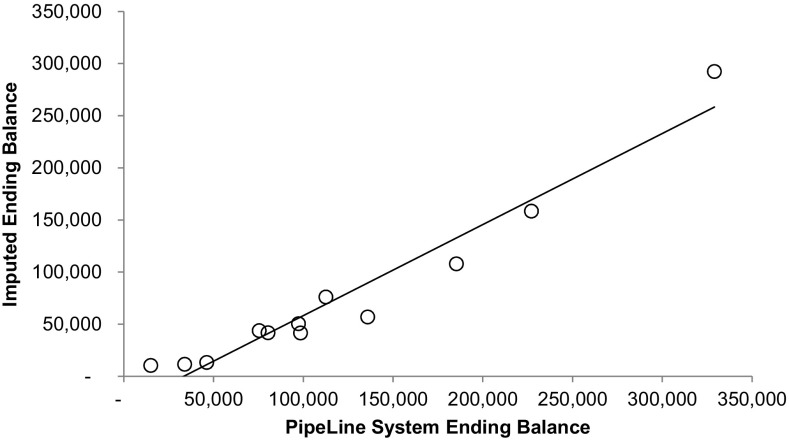
Burkina Faso Scatter Plot of PipeLine Reported System Inventory and Imputed Ending Balance for the Same Reporting Months